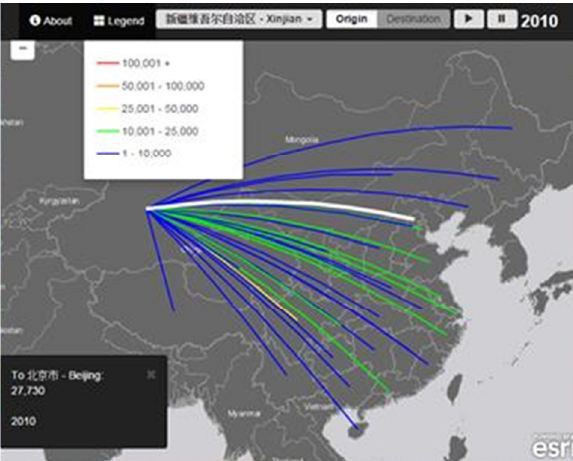
Figure 6d Migration out from Xinjiang in